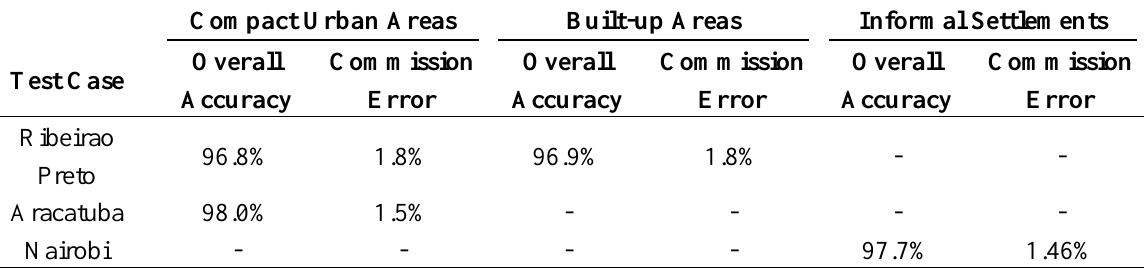
Table 1. Mapping accuracy and commission errors for the three test